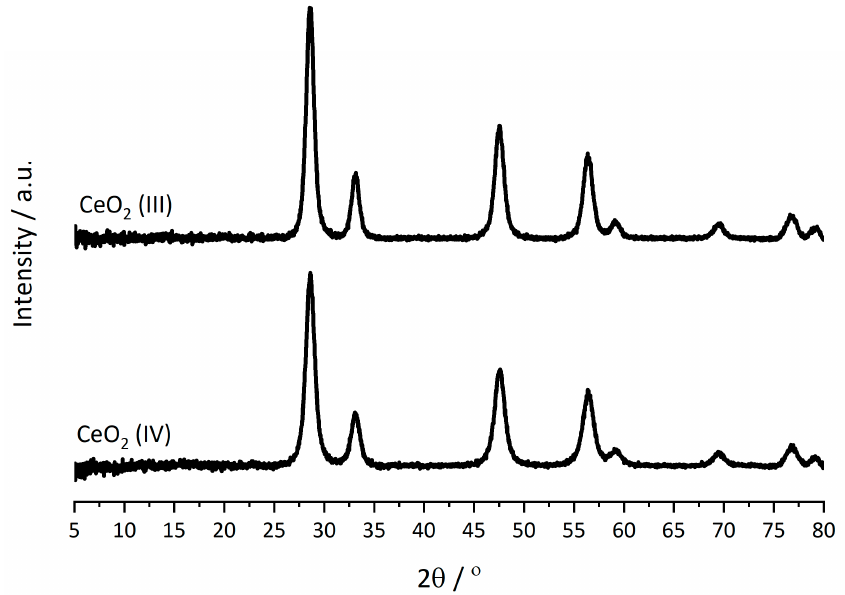
Figure 6. Powder X-ray diffraction patterns of the CeO 2 catalysts.